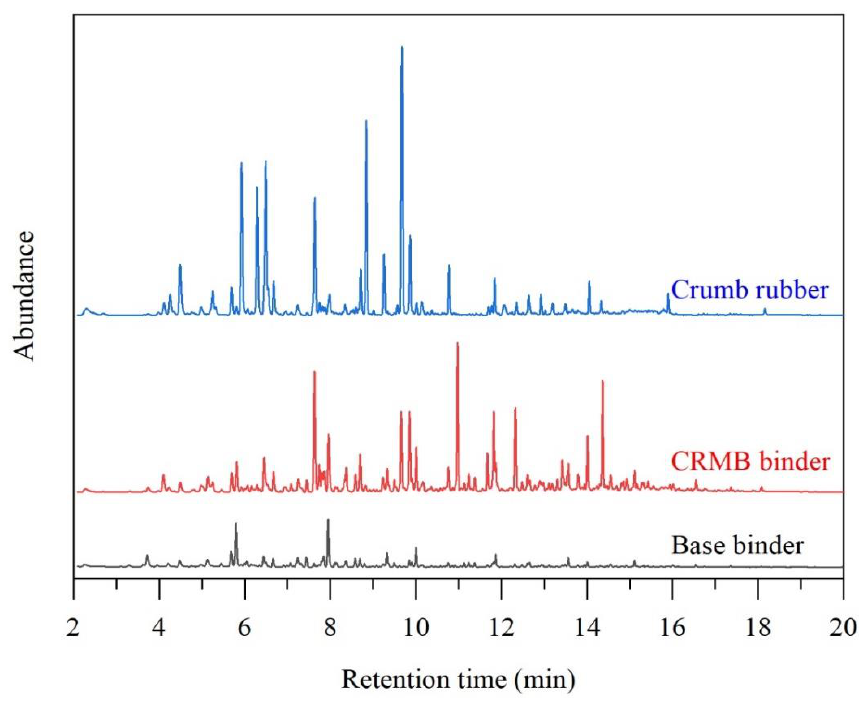
Figure 3. VOCs GC-MS chromatograms of CR powder, base, and CRMB binders.